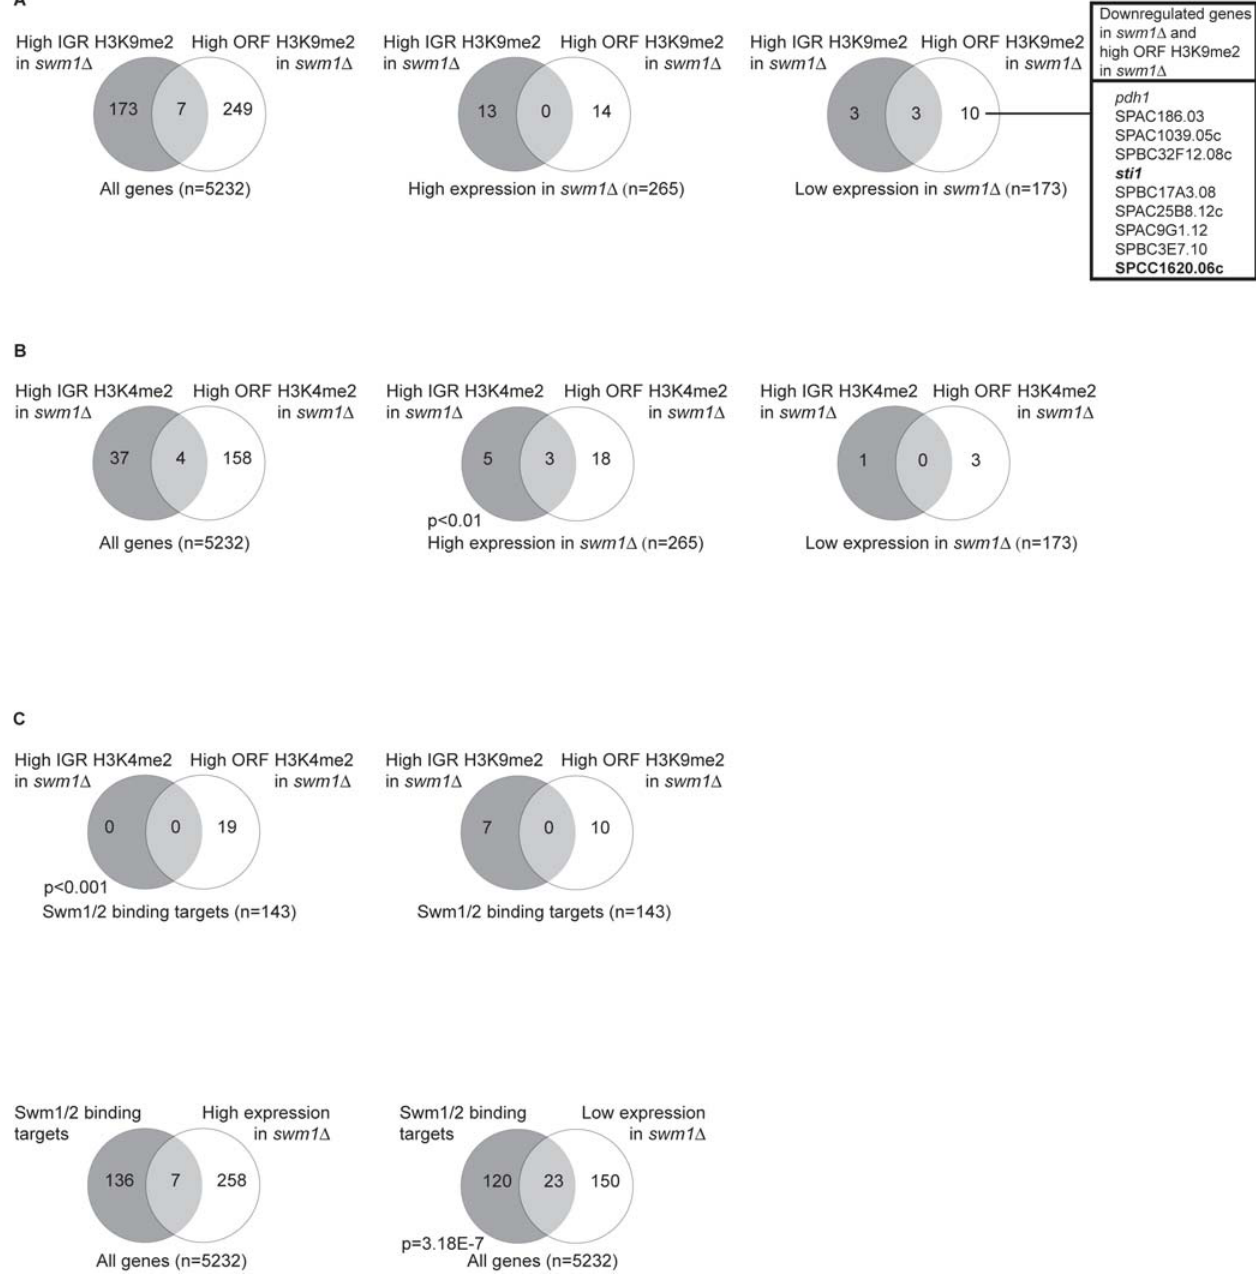
Figure 4. Genome wide analysis of histone methylation and gene expression in swm1 cells, and binding of Swm1/2. A ) A comparison of increased H3K9me2 and altered gene expression in swm1 deletion cells. The Venn diagrams illustrate the degree of overlap between lists of IGR and ORF regions having high H3K9me2 in swm1 deletion cells (using a cutoff value of 2.0 ), and a list of genes, which showed altered expression in swm1 D (using a cutoff value of 1.5). Left: 8.2% of total S. pombe genes showed high IGR or ORF H3K9me2 levels in swm1 D . Middle: The Venn diagram shows the fraction of genes up-regulated in swm1 D having high IGR or ORF H3K9me2. Right: The Venn diagram shows the fraction of genes down-regulated in swm1 D having high IGR or ORF H3K9me2. The inserted table shows a list of 10 genes down-regulated in swm1 deletion cells, which also show high H3K9me2 ORF levels in swm1 D (Swm1/2 binding targets are indicated in bold). B ) A comparison of increased H3K4me2 and altered gene expression in swm1 deletion cells. The Venn diagrams illustrate the degree of overlap between lists of IGR and ORF regions having high H3K4me2 in swm1 deletion cells (using a cutoff value of 2.0 ), and a list of genes, which showed altered expression in swm1 (using a cutoff value of 1.5). Left: 3.8% of total S. pombe genes showed high IGR or ORF H3K4me2 levels in swm1 D . Middle: The Venn diagram shows the fraction of genes up-regulated in swm1 D having high IGR or ORF H3K4me2. 9.8% of swm1 up-regulated genes showed high IGR or ORF H3K4me2 levels, which is significantly more than expected from the genome average (CHI square, P , 0.01; indicated). Right: The Venn diagram shows the fraction of genes down-regulated in swm1 D having high IGR or ORF H3K4me2. C ) Comparison of Swm1/2 binding targets (determined by Nicolas et al., (2006)), H3K4me2 and H3K9me2 levels, as well as gene expression changes in swm1 deletion cells. Top: The Venn diagrams illustrate the degree of overlap between lists of IGR and ORF regions having high H3K4me2 and H3K9me2 levels (as indicated) in swm1 deletion cells, and a list of Swm1/2-binding targets. 13.4% of Swm1/2 binding targets showed high IGR or ORF H3K4me2 levels, which is significantly more than expected from the genome average (CHI square, P . 0.001; indicated). Bottom: The Venn diagrams illustrate the degree of overlap between the list of Swm1/2-binding targets and gene expression changes in swm1 deletion cells. Bottom right: A significant proportion of s wm1 down-regulated genes (hypergeometric P value indicated) were defined as Swm1/2-binding targets. (Note that our microarray contains only 143 of the 175 targets published by Nicolas et al., (2006).) doi:10.1371/journal.pone.0000386.g004 PLoS ONE |